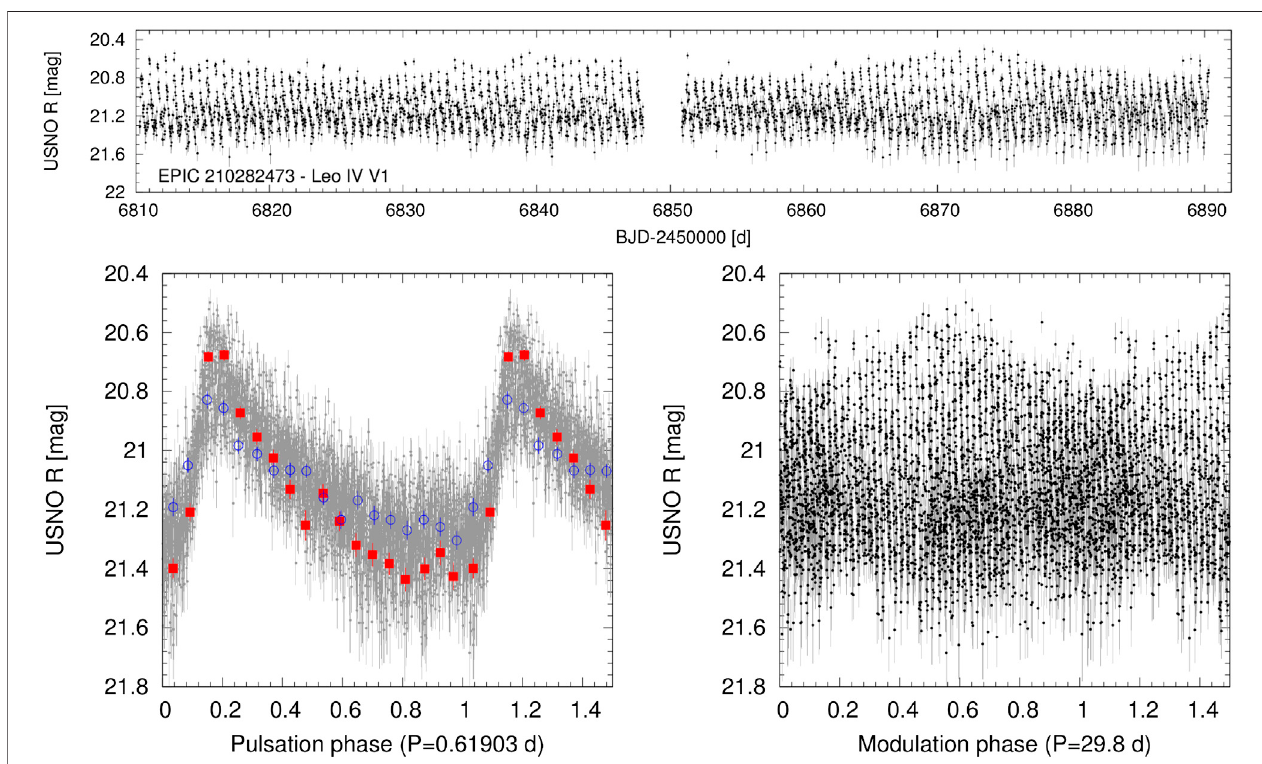
FIGURE7| ThefaintestBlazhkostarfromtheK2mission,EPIC210282473(LeoIVV1). Upperpanel: theK2lightcurve. Lowerleftpanel: phasecurvefoldedby the pulsation period, 2-day binned data from the maximum-amplitude phase (red) and minimum-amplitude phase (blue) are marked. Lower right panel: phase curve folded with the modulation period. Figure reproduced from Figures 3 and 5 in Molnár et al. (2015) copyright AAS. Reproduced with